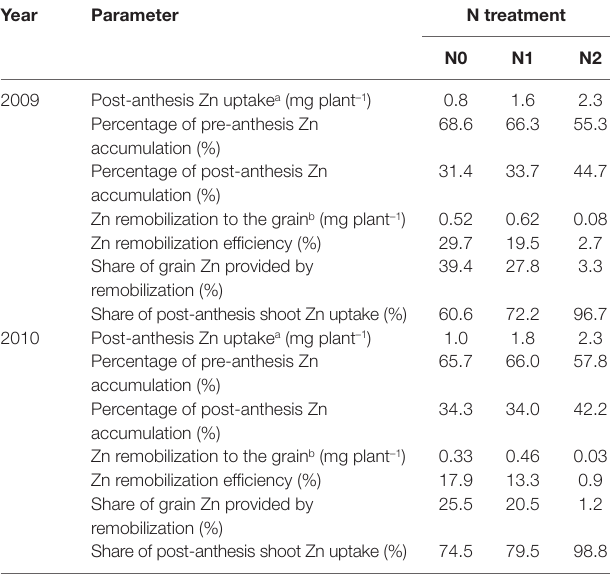
TABLE 3 | Straw remobilization ratios and contributions of remobilization of pre- silking Zn stores and post-silking shoot Zn uptake to grain Zn accumulation of summer maize as affected by N application rates in 2009 and in